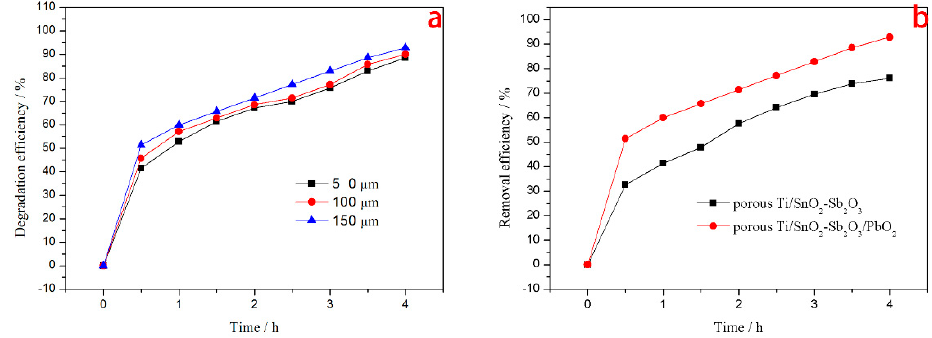
Figure 7. ( a ) Effect of pore size on chloride ion removal efficiency; ( b ) chloride ion removal efficiency as observed with 150 µm porous Ti/SnO 2 -Sb 2 O 3 and 150 µm porous Ti/SnO 2 -Sb 2 O 3 /PbO 2